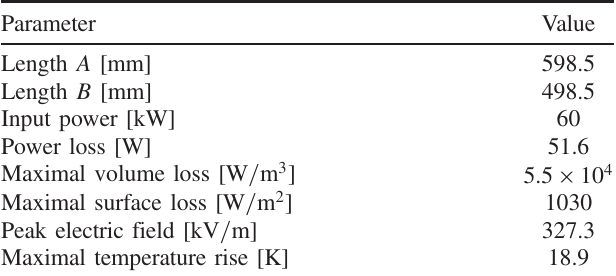
TABLE IX. rf and thermal analysis results of the